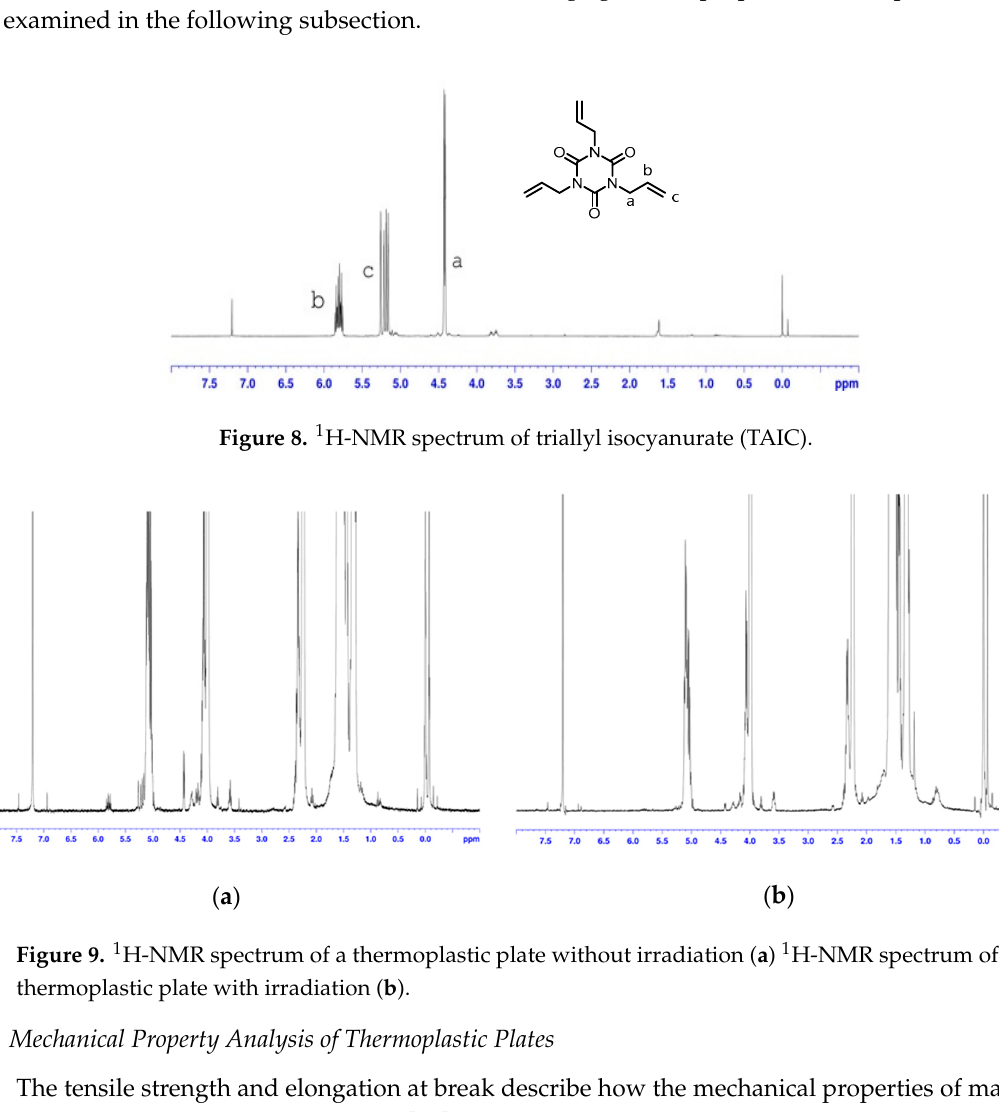
Figure 9. 1 H-NMR spectrum of a thermoplastic plate without irradiation ( a ) 1 H-NMR spectrum of a thermoplastic plate with irradiation ( b ).